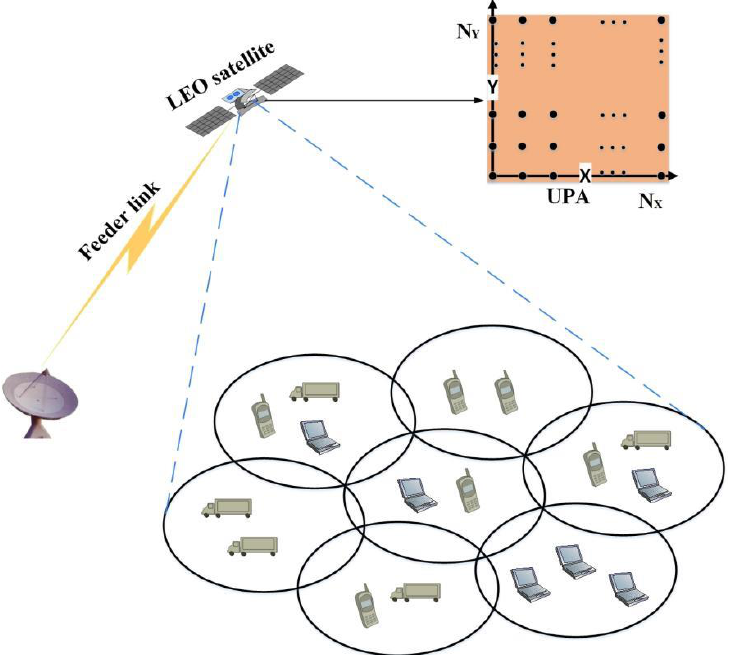
Figure 1. Transmission model of the massive MIMO LEO satellite multigroup multicast communi- cation system.